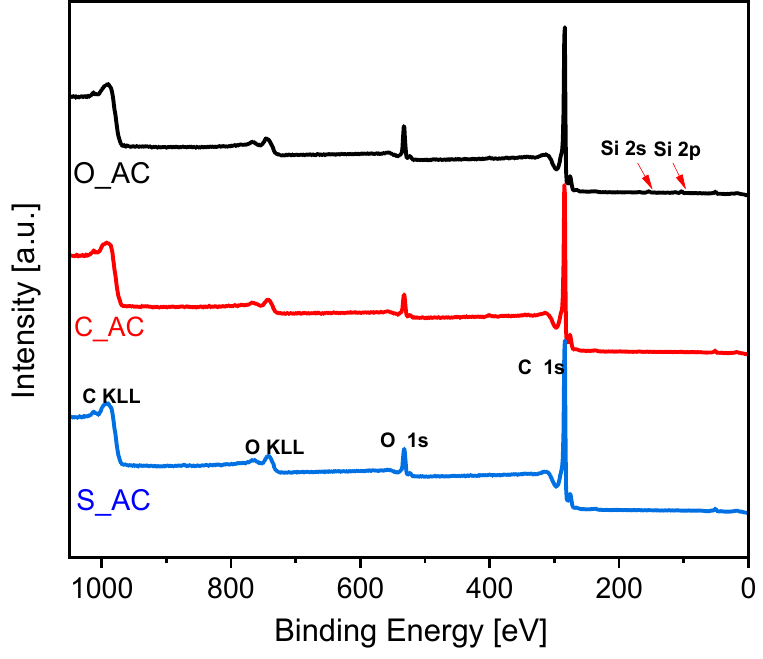
Figure 6. Survey X-ray photoelectron spectra.